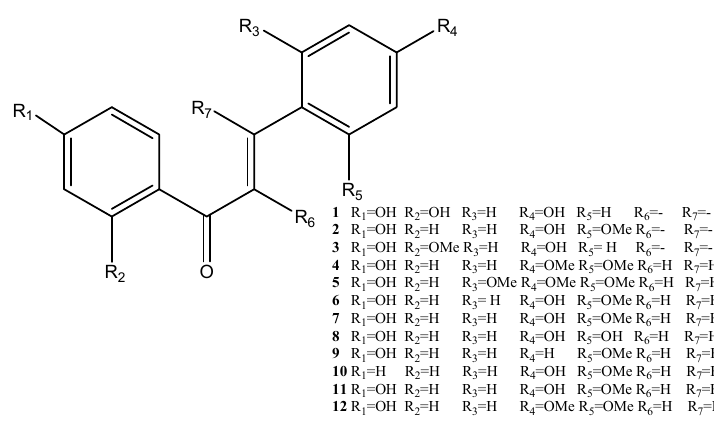
Figure 2. Structures of chalcones and dihydrochalcones.